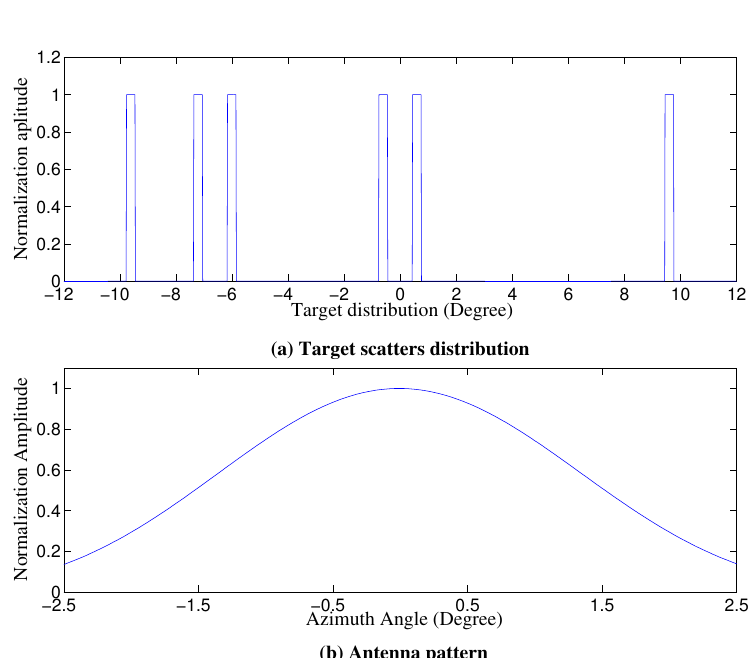
Figure 2. Extended point targets distribution and antenna